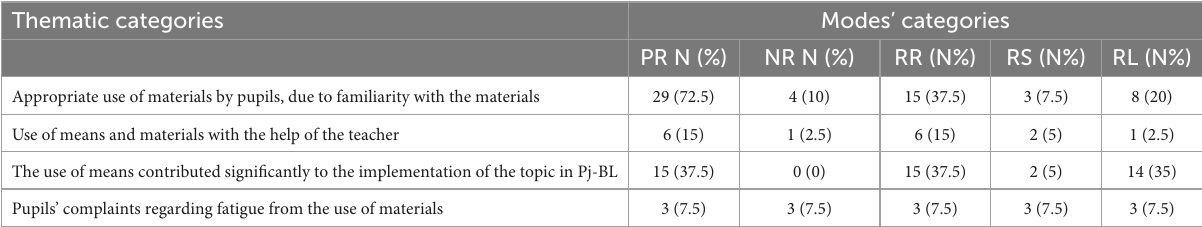
TABLE 3 Pre-service teachers’ modes of expression on the use of means and materials during the project-based learning (Pj-BL) approach. Thematic